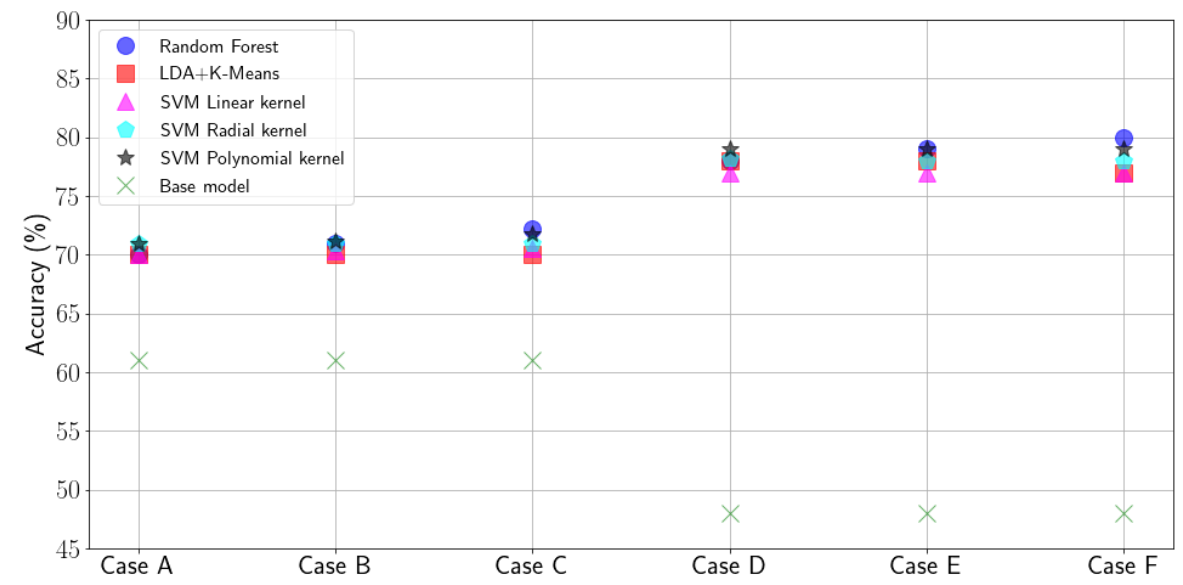
Figure 9. Comparative of the prediction accuracy obtained by the evaluated classifiers.